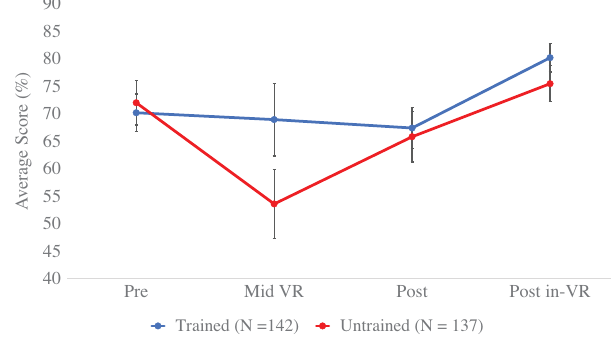
FIG. 6. Average scores at different time points on questions posed in different media, separated by treatment